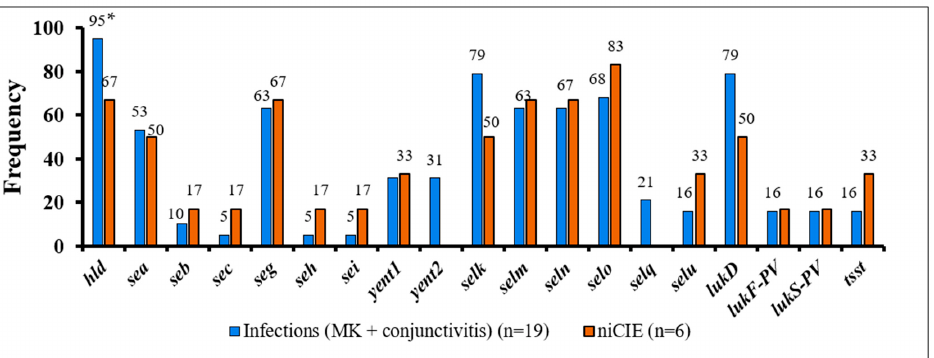
Figure 5. Frequency of 19 enterotoxins, exfoliative toxins and tsst in S. aureus by disease group. *, trend more common in infectious strains ( p = 0.1).